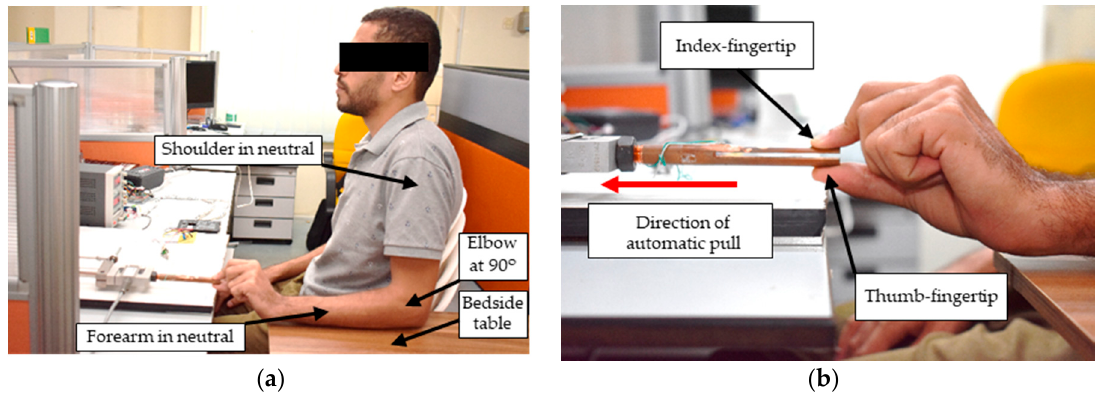
Figure 10. ( a ) Body and upper limb positioning during the experiment; and ( b ) thumb and index finger opposed onto the pincer object. Note that the volunteer should resist the automatic pull applied by the linear actuator